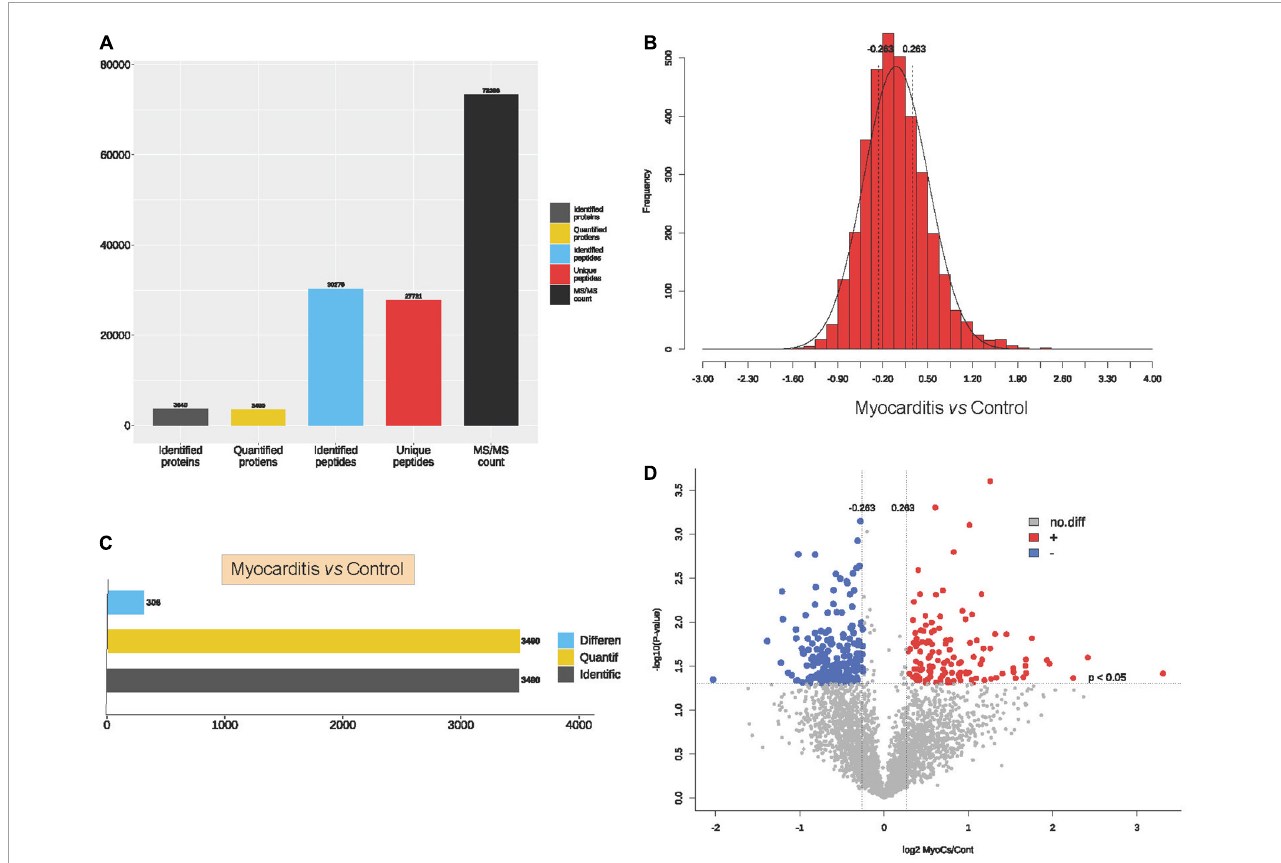
FIGURE2 Identification of proteins in immune checkpoint inhibitors (ICI)-related myocarditis. (A) Overview diagram of protein identification. (B) Quantitative ratio distribution map of immune myocarditis and normal myocardial tissue. (C) Differential protein screening between immune myocarditis and normal myocardial tissue. (D) Volcano map of differential protein